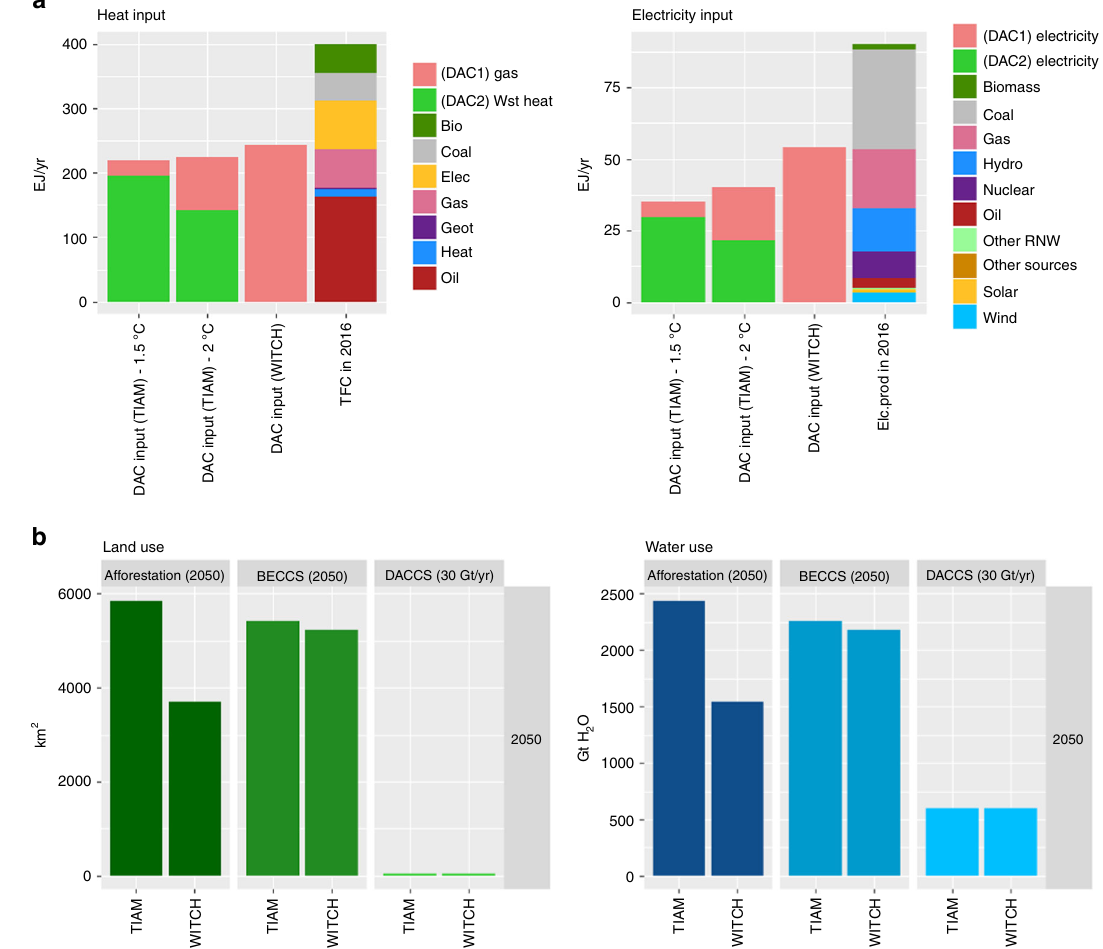
Fig. 6 Impact of DACCS in terms of energy input, land and water use. a shows the energy input required to operate DACCS plants capturing about 30 GtCO 2 /year. Note that from TIAM-Grantham we have a differentiation among the two DACCS technologies, with different heat sources, while in WITCH we only have gas- fi red DAC1 plants. Heat and electricity inputs are compared with the 2016 Total Final Consumption and electricity production respectively, as reported by the International Energy Agency 43 . b shows the amount of land and water used by DACCS plants to capture 30 GtCO 2 /year compared to BECCS and afforestation 5 , when these are deployed at the levels foreseen by the models in